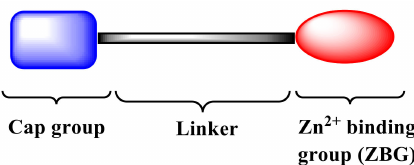
Figure 1. Pharmacophoric model of the designed histone deacetylases inhibitors